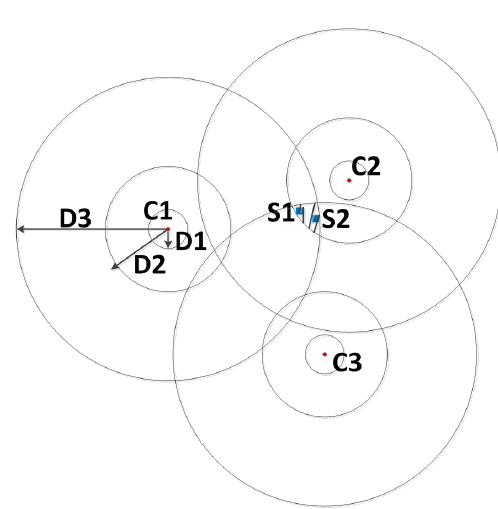
Figure 10. Charging area